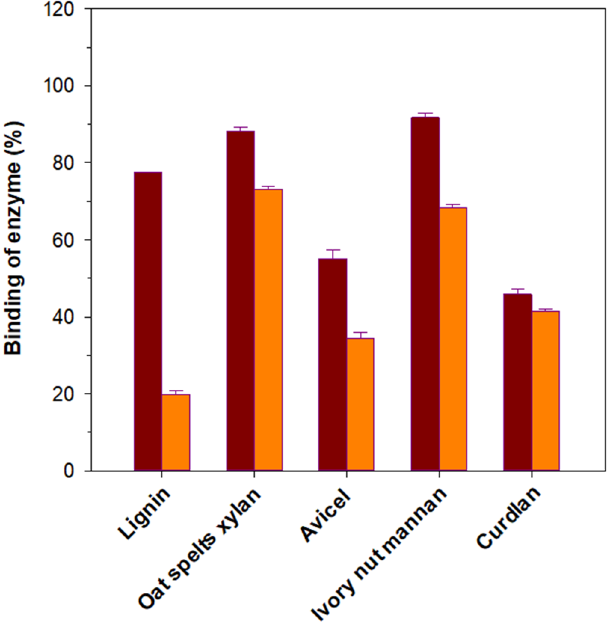
Figure 6. Binding of rGluY ( ■ ) and rGluY Δ RICIN ( ■ ) to insoluble polymers. The values are mean ± SD of triplicate tests.